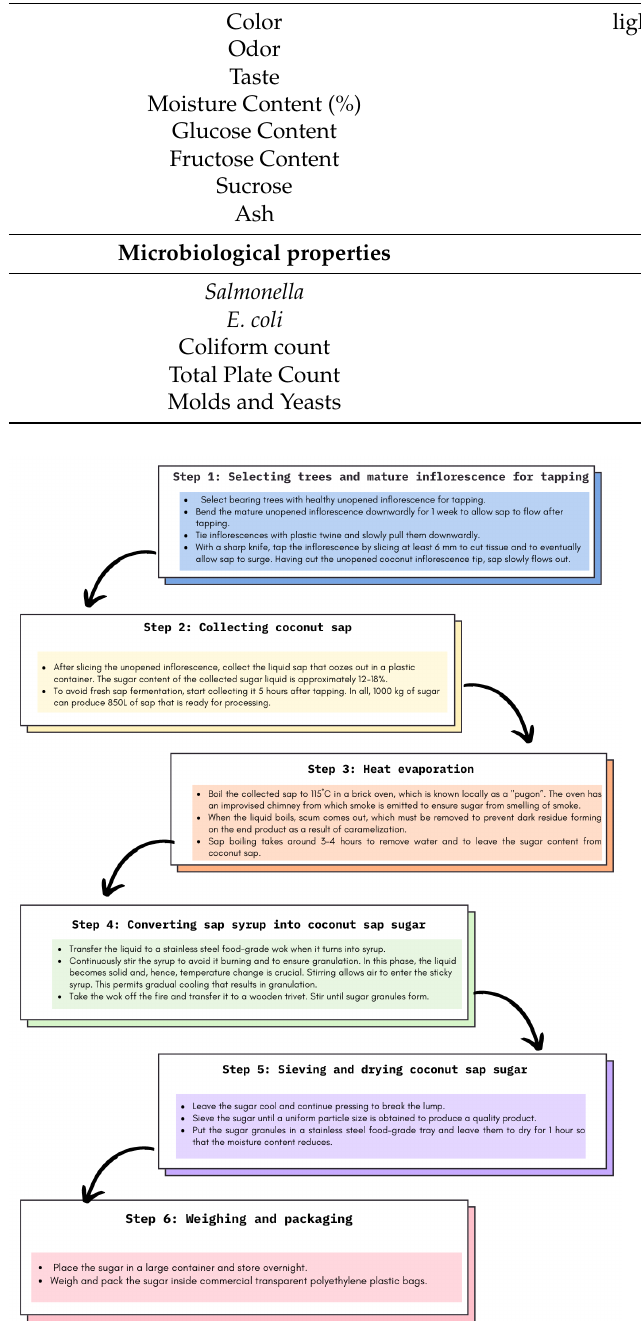
Figure 2. Recommendations for coconut sap sugar production in the Philippines. Adapted from Refs. [17,70,74,77].